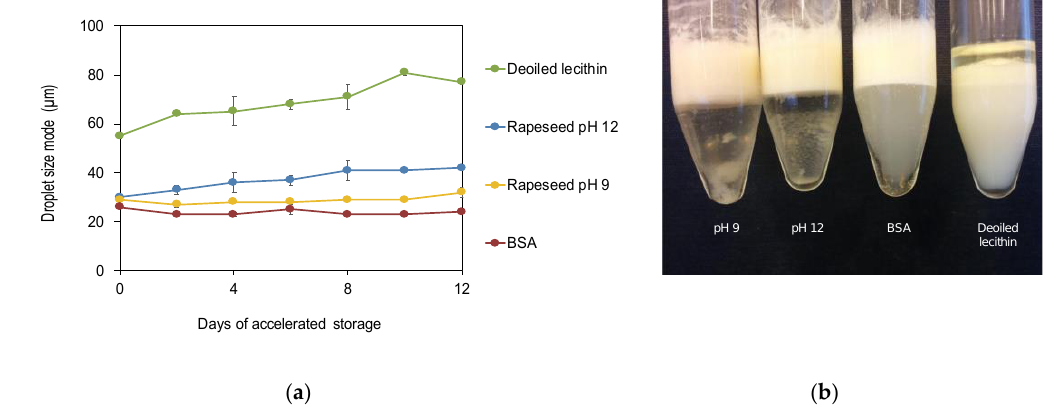
Figure 5. ( a ) Droplet size evolution of fish oil emulsions (mode) incubated at 30 °C for 12 days. Data is an average of six measurements from two replicates of emulsions. ( b ) Emulsions with fish oil after 12 days of storage at 30 °C. pH 9 is rapeseed protein extracted at pH 9, pH 12 is rapeseed protein extracted at pH 12, BSA is bovine serum albumin. 8 mg protein/mL oil (8 mg dry matter of de-oiled lecithin) was used to formulate 30% oil-in-water emulsions.